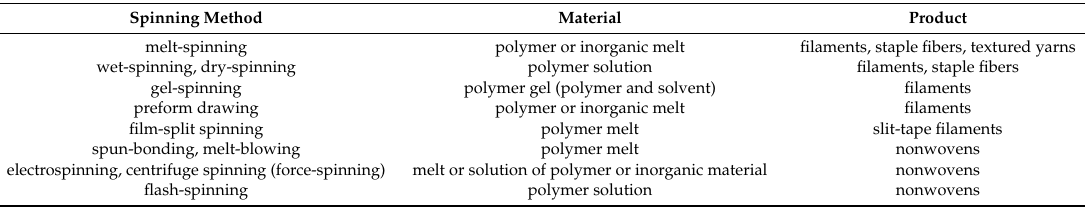
Table 1. List of fiber spinning